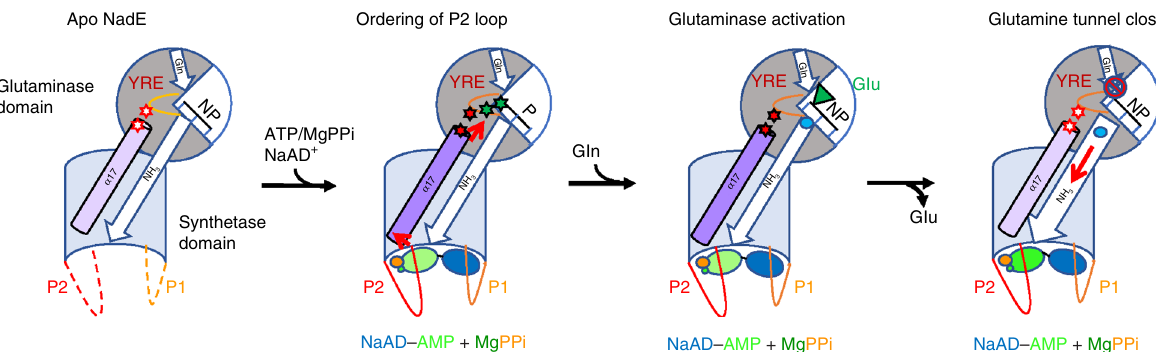
Fig. 7 Proposed shared steps in hsNadE and tbNadE for the glutaminase activation. Dash and solid curved lines represents disorder and ordered loops, respectively. NP and P indicate a non-productive and a productive glutaminase active site, respectively. Light and dark purple coloring of α -17 indicate the absence or presence of activating interactions with the YRE loop. Similarly, white and color fi lled stars represent the absence or presence of interactions between α -17 and YRE loop (in red), and YRE and the catalytic triad (in green). Orange, green, dark blue, and light blue spheres represent PPi, the AMP, and NaAD + moiteties of NaAD – AMP, and ammonia. The green fi lled triangle represents glutamate. The “ no access ” sign shows the gating mechanism that blocks access to the glutamine tunnel. The addition of Gln is shown in the model after formation of the NaAD – AMP for simplicity but the order of its addition remains unclear.